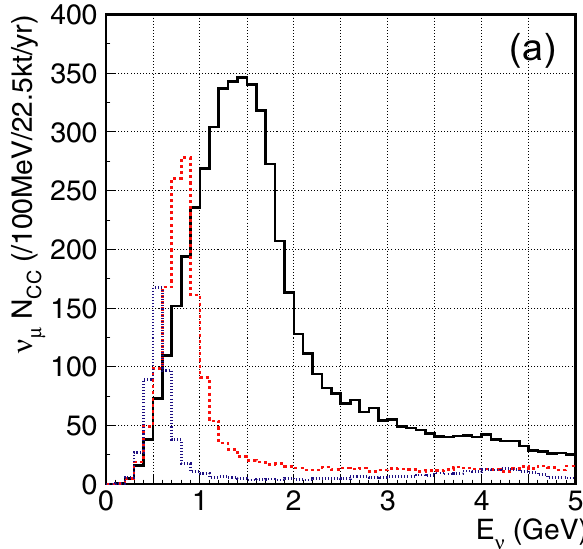
Fig. 42 Neutrino energy spectra of charged current interactions. Thick solid (black), dashed (red), and dash-dotted (blue) histograms are the spectra with the off-axis angles of 1 ◦ , 2 ◦ , and 3 ◦ , respectively